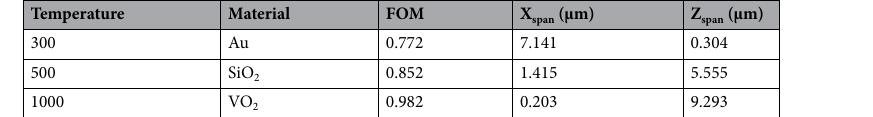
Table 2. Identified optimal material(s) and geometries that maximize the cooling figure of merit equation Eq. (4).